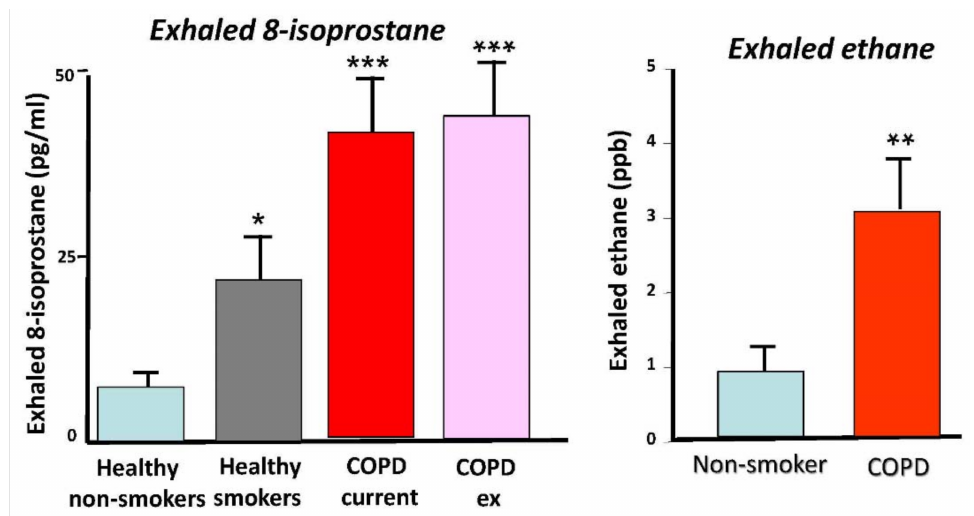
Figure 2. Increased markers of oxidative stress in the breath of COPD patients. Left panel shows increased concentrations of 8-isoprostane in exhaled breath condensate from normal smokers and a greater increase in COPD patients. Ex-smokers have a similar level of 8-isoprostane to active smokers, indicating endogenous oxidative stress from chronic inflammation in the lungs (adapted from ref. [37]). Right panel shows increased exhaled ethane (measured by gas-chromatography mass spectrometry) in COPD patients compared with smokers (adapted from reference [33]). Difference from normal controls: * p < 0.05, ** p < 0.01, *** p <